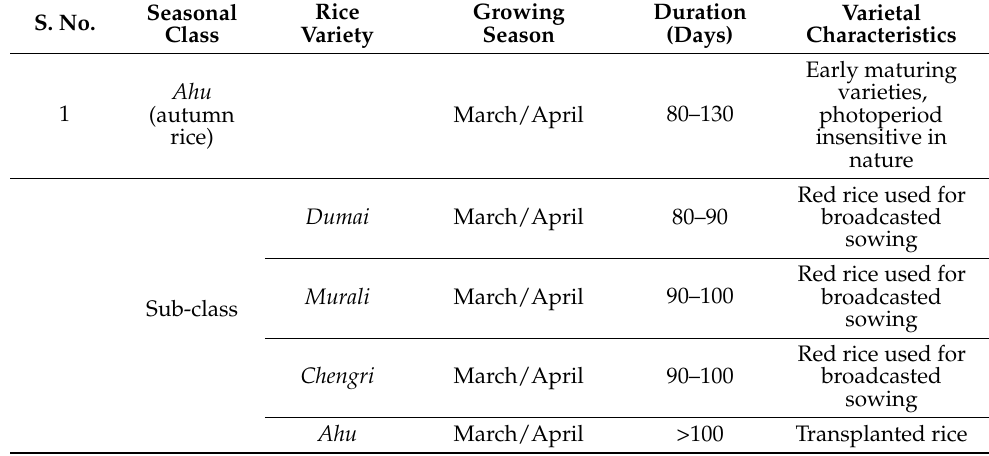
Table 8. Traditional rice varieties of Assam in North-Eastern Region. S.